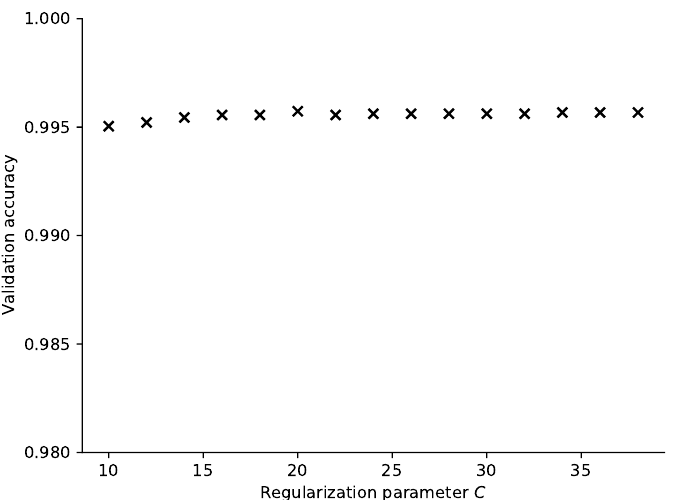
Figure 11. Accuracy of prediction achieved for a varying regularization parameter C in the SVM classifier.